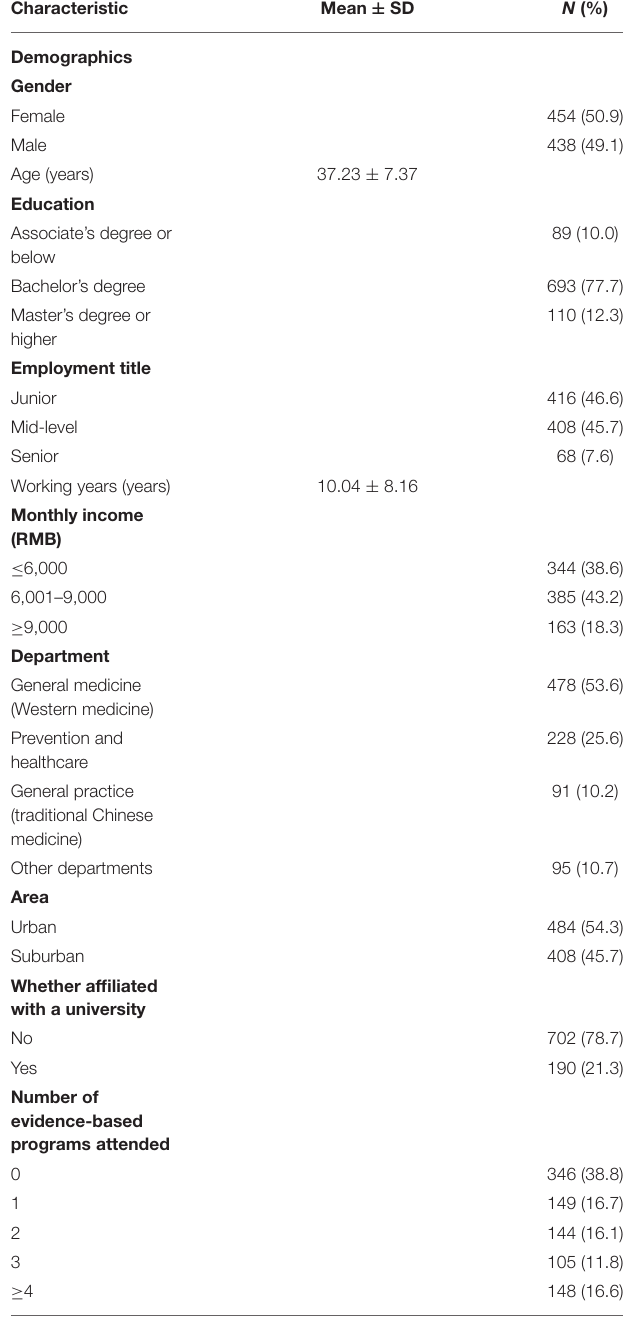
TABLE 2 | Characteristics and perceived impeding factors of the respondents ( n =